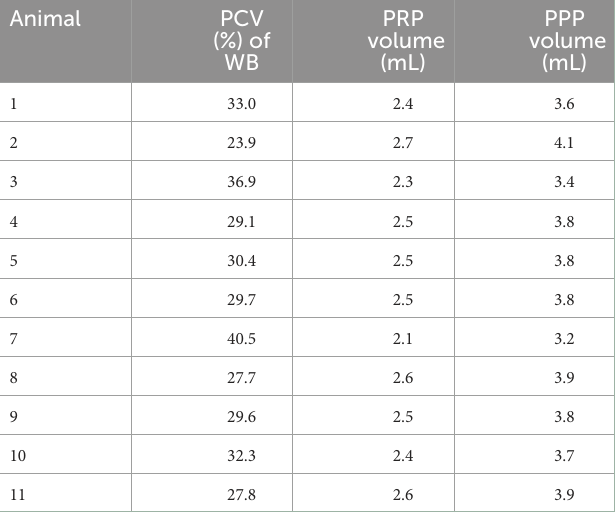
TABLE 4 Individual packed cell volume (PCV; %) and recovered volumes of PRP (mL of plasma corresponding to the bottom 40% of the total plasma fraction) and PPP (mL of plasma corresponding to the top 60% of the plasma fraction) for each cat.